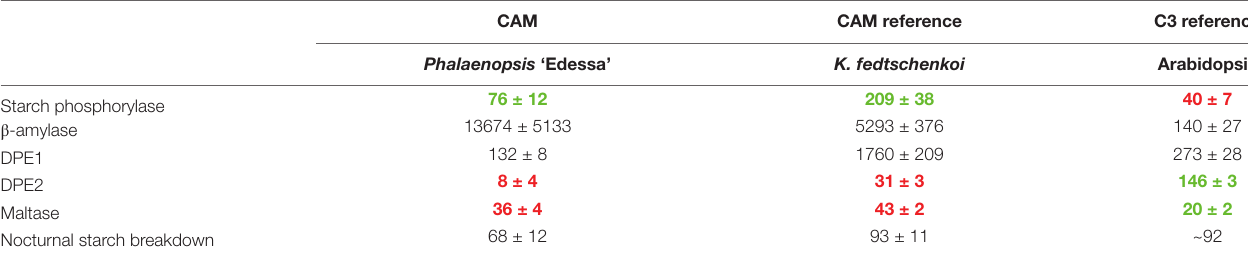
Data are means ± SD (n = 5). Values for Arabidopsis originate from Chia et al. (2004). Different colors have been used to indicate whether the relevant enzymatic capacities in either starch phosphorolysis (starch phosphorylase) or hydrolysis (DPE2 + maltase) are adequate (green) or inadequate (red) to accommodate the observed starch